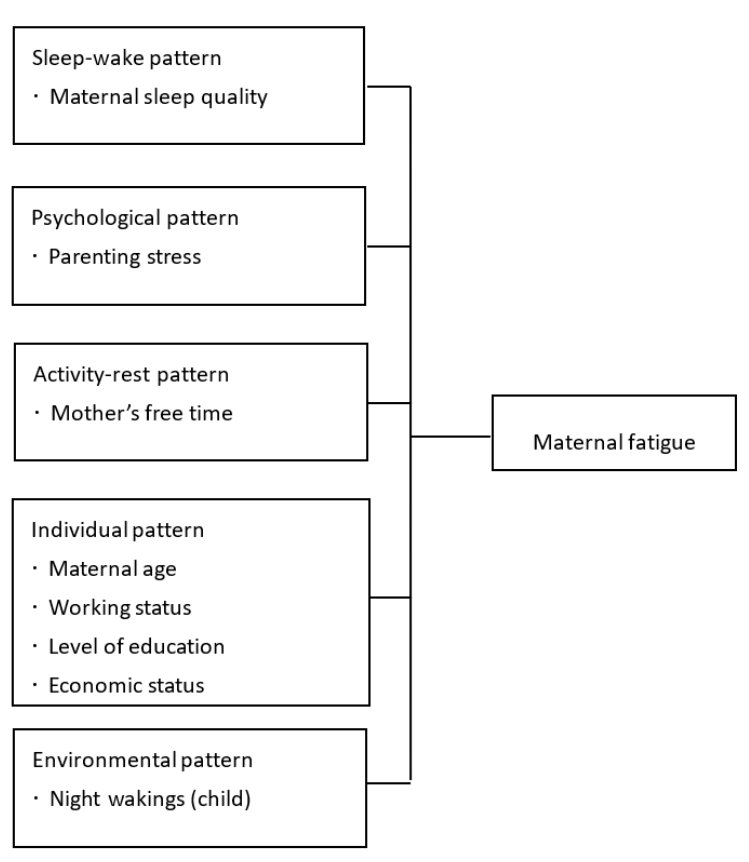
Figure 1. Conceptual Framework of the Study.